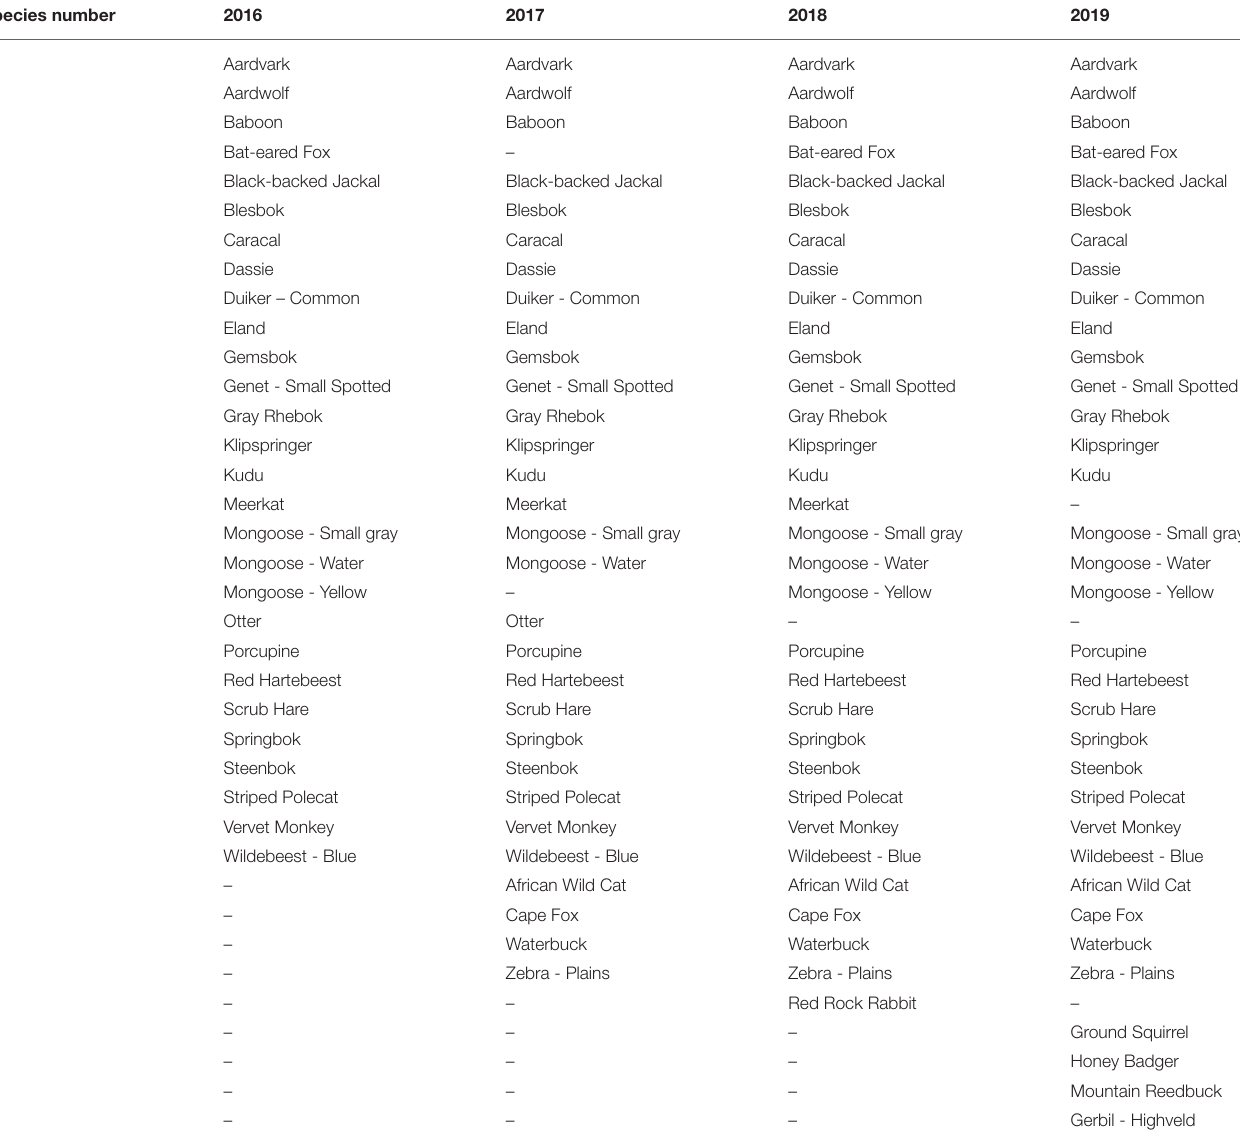
TABLE 1 | Species detected per sample period (July to December of each year) on the wildlife-friendly farm. Species